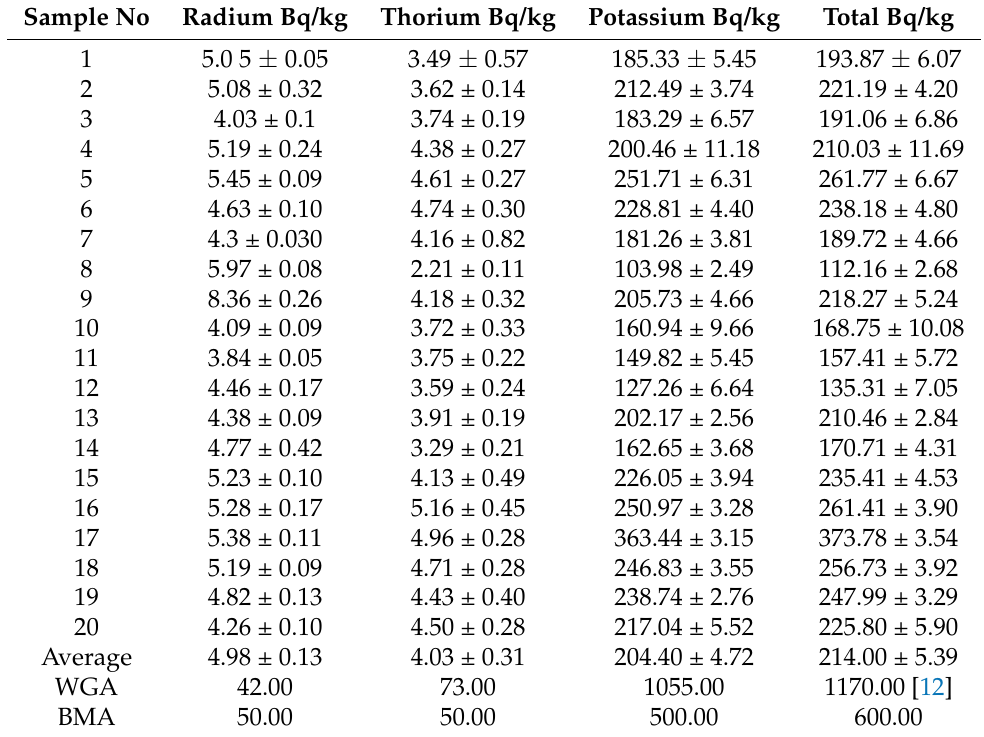
Table 1. Ray activities of 226Ra, 232Th, 40K, and their total in the Bajaur Norite. The following abbreviations are used in the table WGA = World GranitesAverages, BMA = Building Material